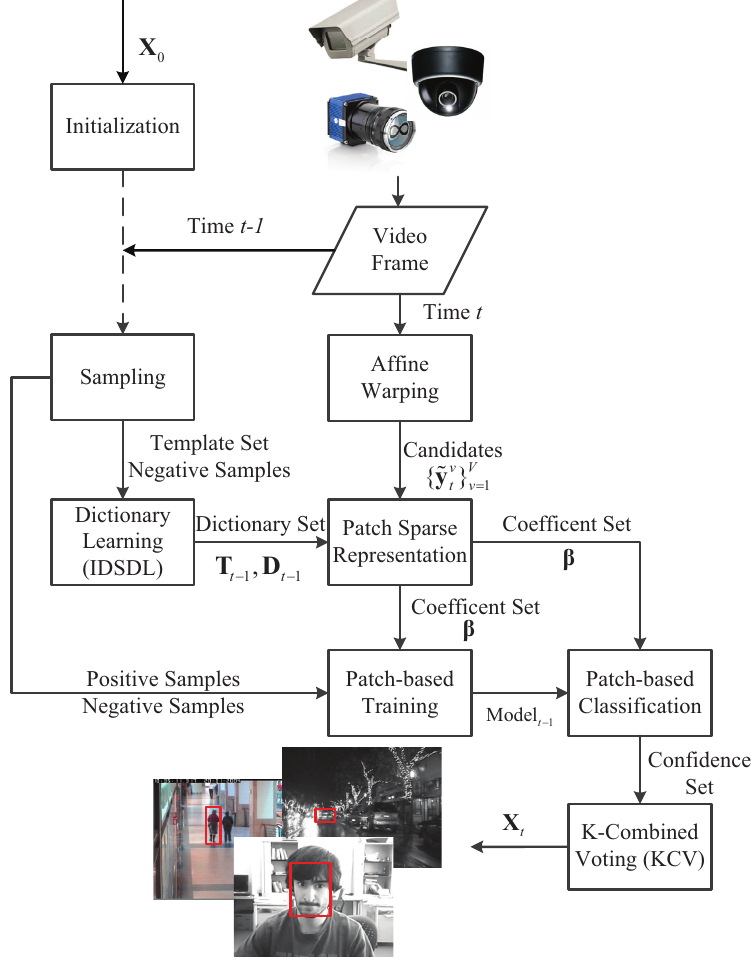
Figure 1. Workflow of the proposed algorithm. The proposed dictionary learning method, incremental discriminative structured dictionary learning (IDSDL), is detailed in Section 2, while the proposed affine warping, support vector machine (SVM) training and classification and K-combined voting (KCV) are detailed in Section